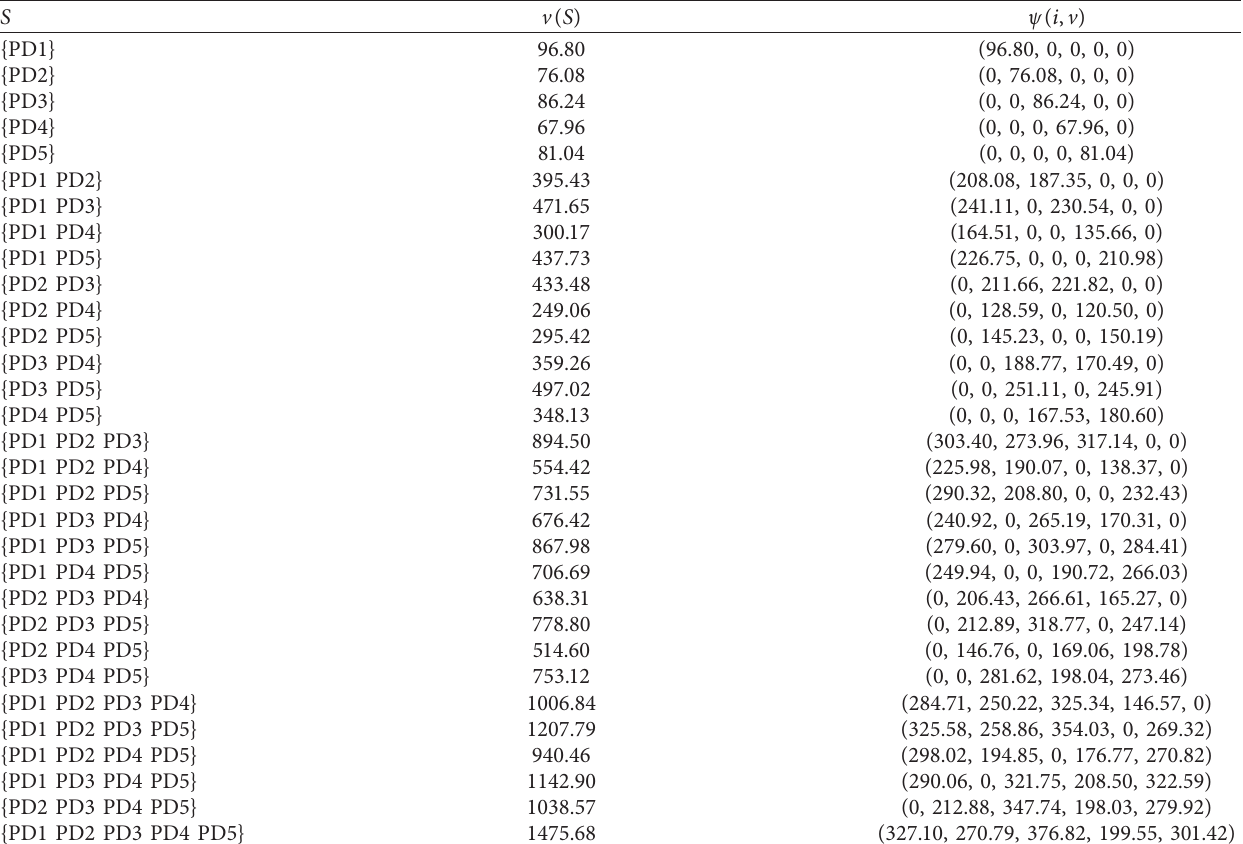
Table 12: Cost allocation in the CMPSRPMT optimization with one alliance (unit: USD).